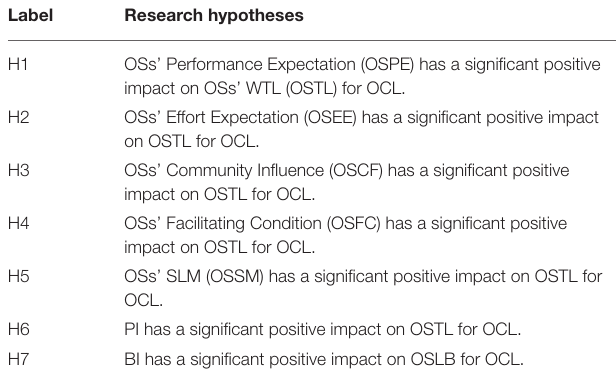
TABLE 1 | Research